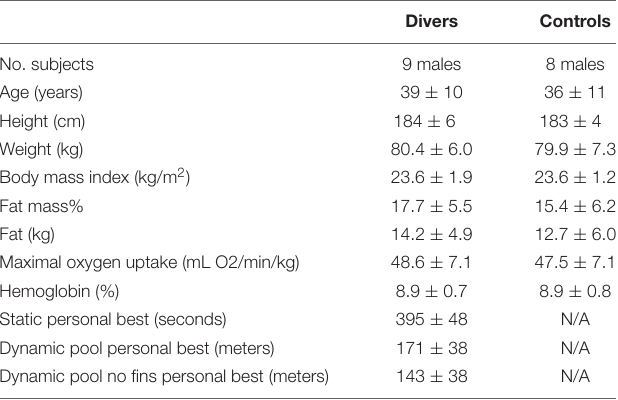
TABLE 1 | Subject characteristics.